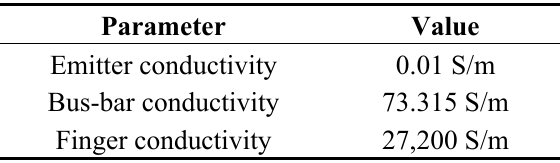
Table 4. Model boundary condition inputs.